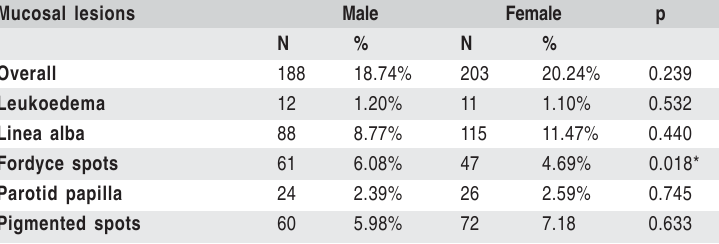
Table 4 - Normal variations of oral mucous membrane